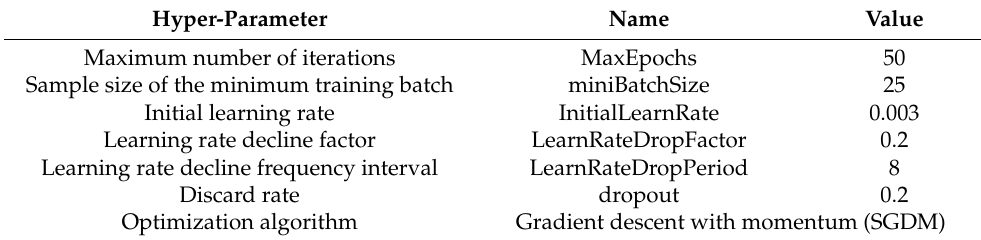
Figure 6. Framework of the CNN-based model. Table 3. Parameters for CNN-based model.